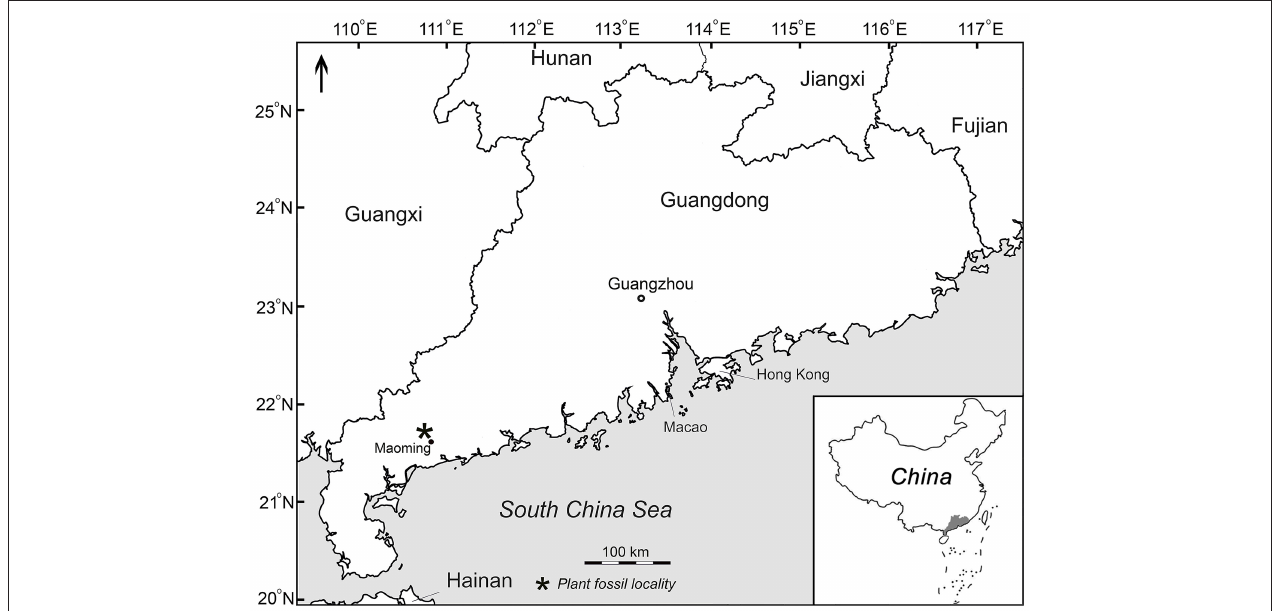
FIGURE 1 | Map showing plant fossil locality (asterisk) in the Maoming Basin, Guangdong Province, South China.